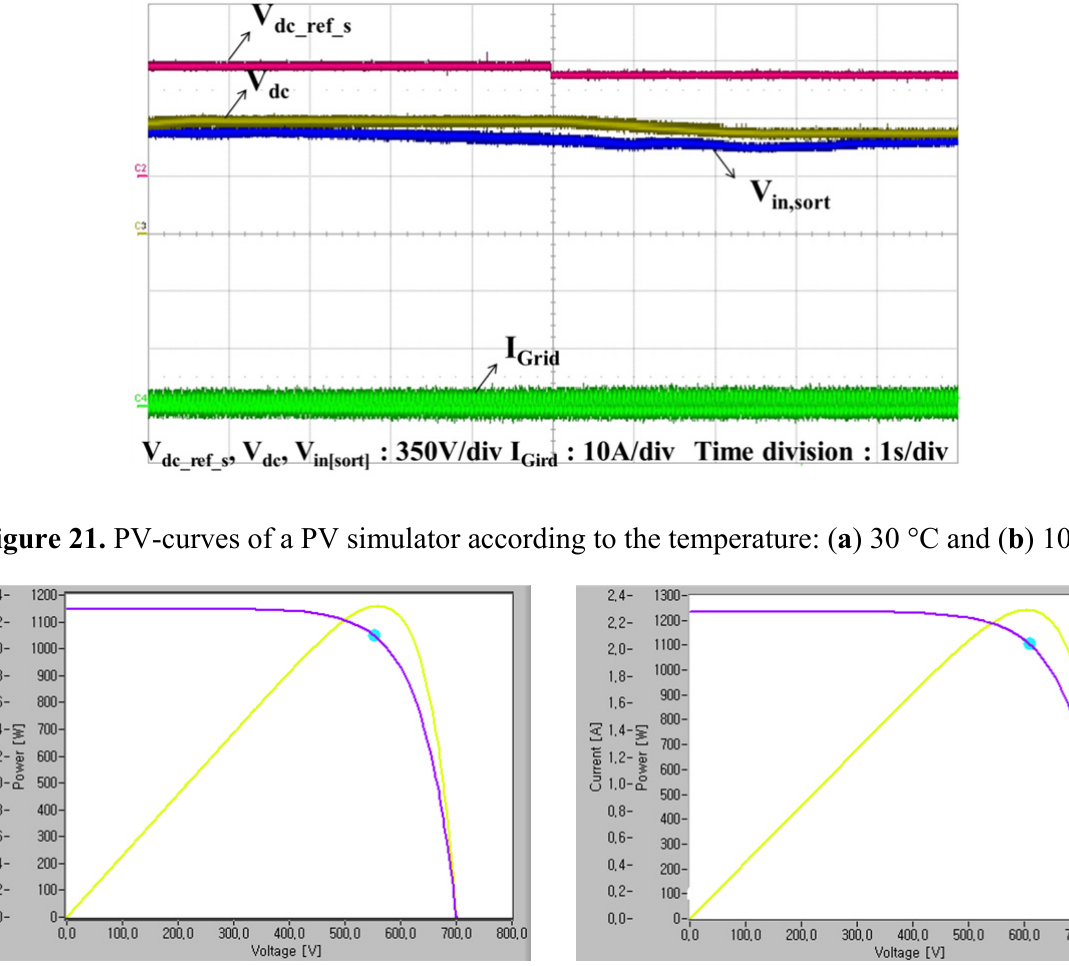
Figure 20. Experimental results for the DC-link voltage, V Figure 11 when the temperatures of PV1 is increased.